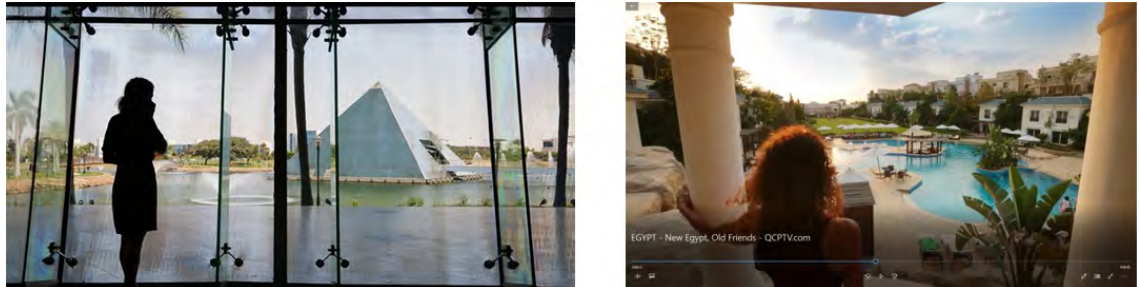
Figure 13. Shows flag ships projectssmart village , mountoin view (New Egypt Old Friends, 2016) City form